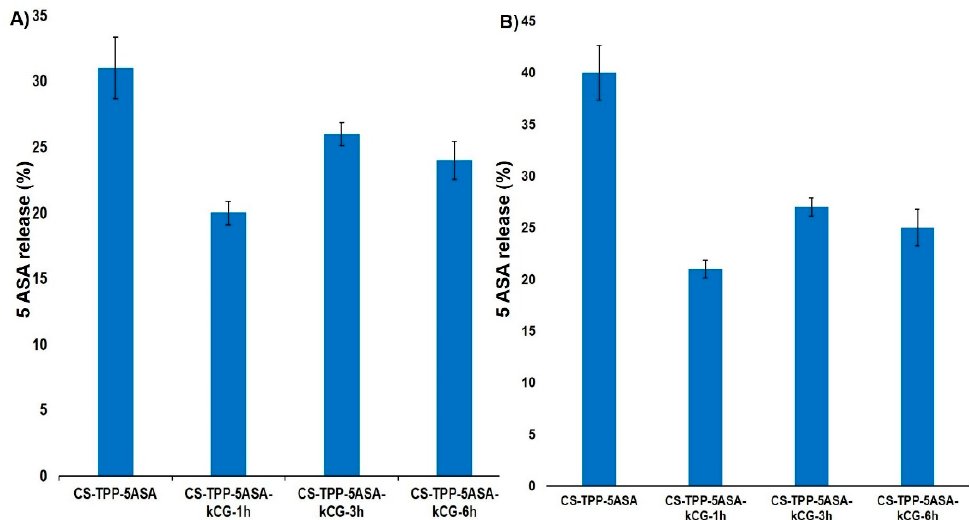
Figure 6. ( A ) Burst release at 15 min and ( B ) drug release after 2 h from the hydrogel beads in SGF at 37 °C.